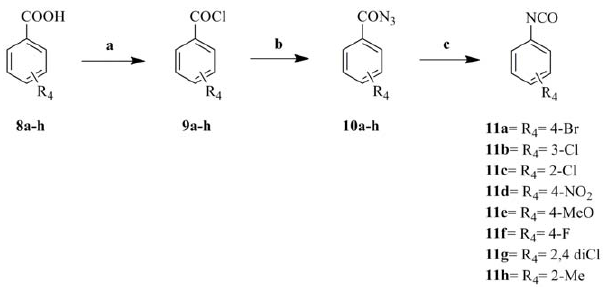
Figure 12. Synthesis of intermediates 11a–h. Reagents and conditions: (a) SOCl 2 , reflux, 5 h; (b) NaN 3 , acetone, 2 10 u C, 30 min; (c) Benzene, 70 u C, 3 hrs.